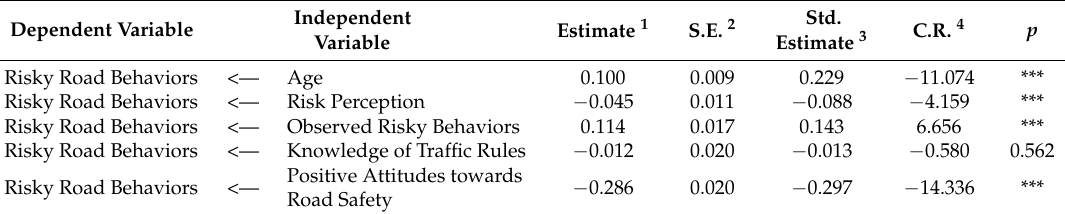
Table 2. Frequency and percentage of each gender and each age group with or without anxiety symptoms.